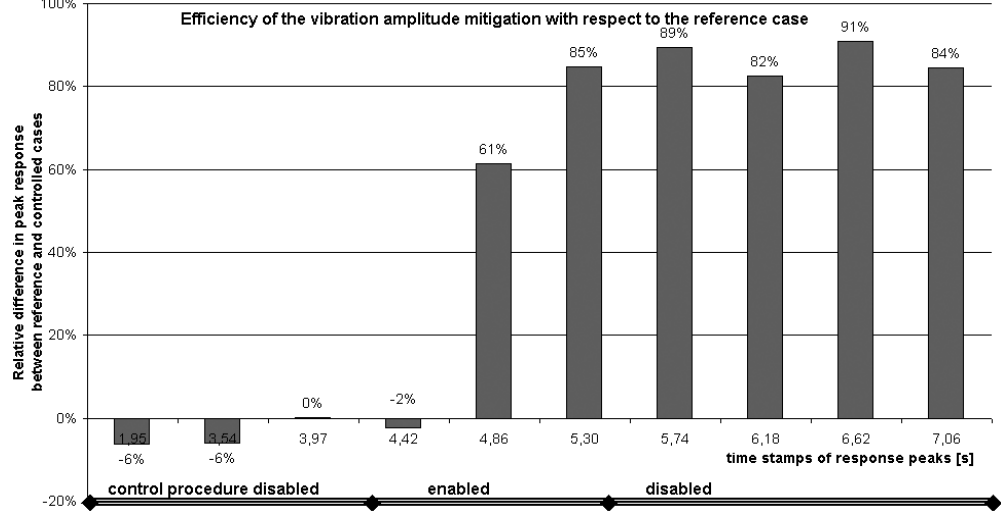
Fig. 17. Relative difference in amplitudes as related to the reference